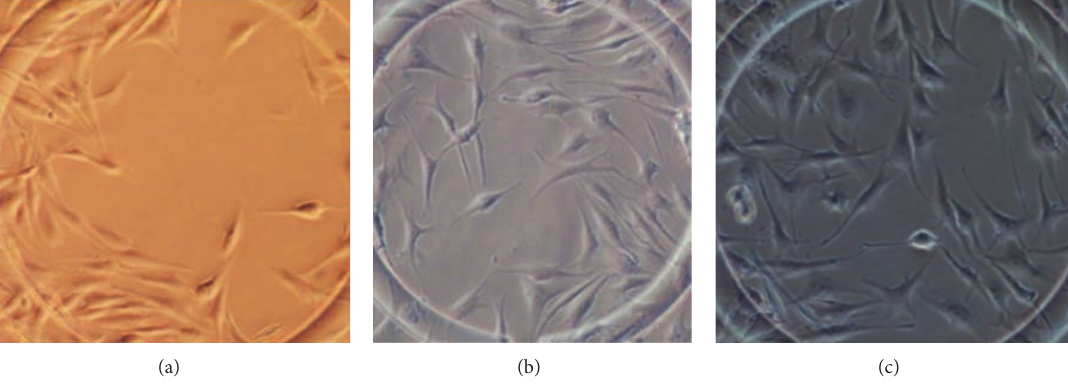
Figure 19: Growth image of M763 cells for different time steps. (a), (b), and (c) are, respectively, growth images of 24 h, 48h, and 72 h. Table 2: The part index of automatic guided space cell culture